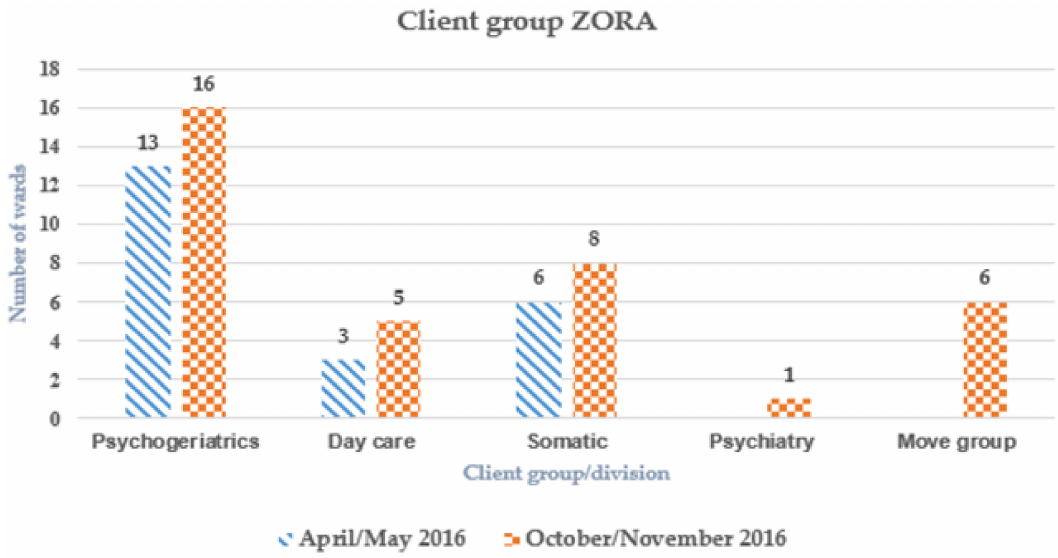
Figure 8. The client groups using Zora given per type of ward (2016): The “Move group” comprises clients who can do exercises to music.